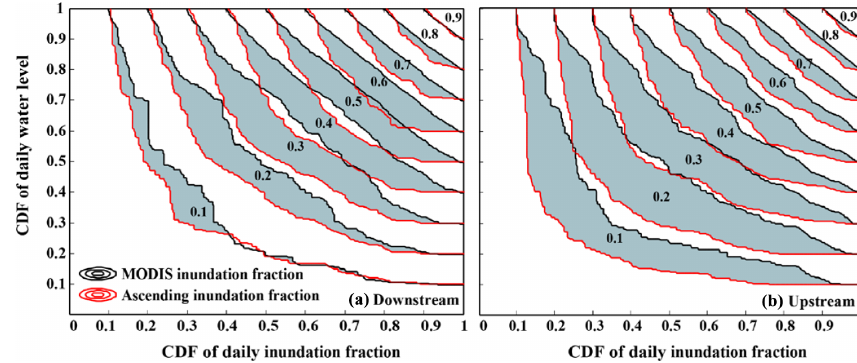
Figure 9. The empirical copula (joint probability distribution of quantiles) of the average daily water level and total daily inundated areas from the proposed retrieval algorithm (red curves) and MODIS-MWP data (black curves) for 2015. These plots indicate that our products have stronger dependence to water levels than the MWP products (more L-shaped curves) for both the downstream (a) and upstream (b) regions of the Mekong Delta. The shaded areas (which quantify the difference between the degree of dependence of our products and the MWP products to the daily water levels) are larger in the upstream region, indicating an enhanced performance of the proposed algorithm to retrieve inundation fraction where potential inundation areas are better defined due to topography, e.g., around major